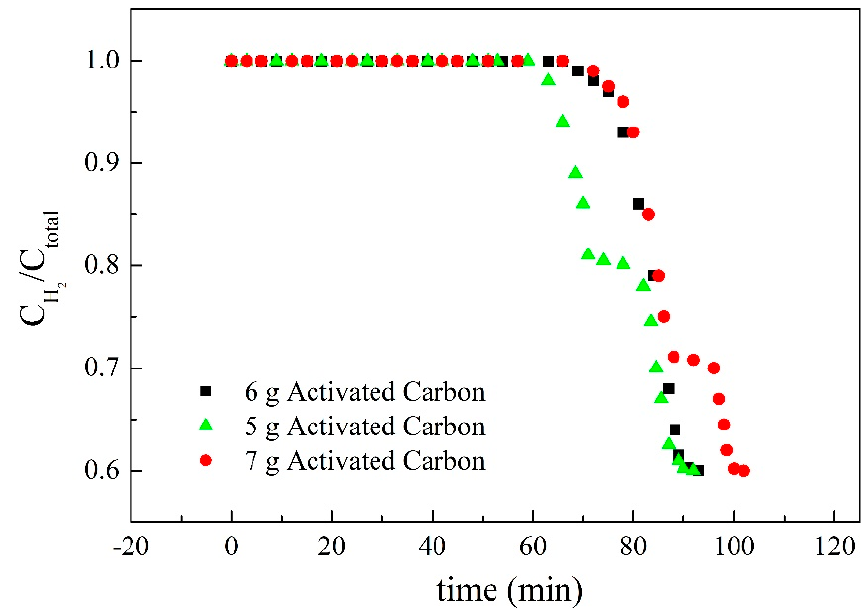
Figure 9. The effect of the addition of activated carbon on the ratio of hydrogen concentration to the total concentration of gas.